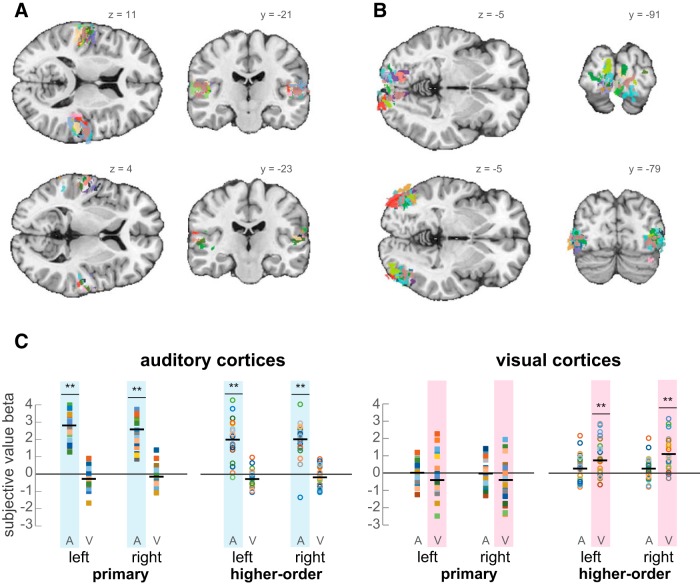
Value modulation of sensory cortices. Individual subjects’ sensory ROIs were defined using functional localizers, and subjective-value β-values were extracted and tested against zero. A, B, For each subject, four contrasts were defined to identify primary and higher-order areas of each modality. Each color represents an individual subject. Upper panels. Primary auditory (A) and visual (B) cortices. Lower panels, Higher-order auditory (A) and visual (B) cortices. C, SV representation in these areas. The y-axis represents the extracted β-values from a GLM, which included four predictors: aSV (denoted A), vSV (denoted V), and two dummy variables for trial (results not shown here). Each colored marker represents an individual-subject’s β-value. Black horizontal lines represent the means; **p < 0.001, Bonferroni corrected.